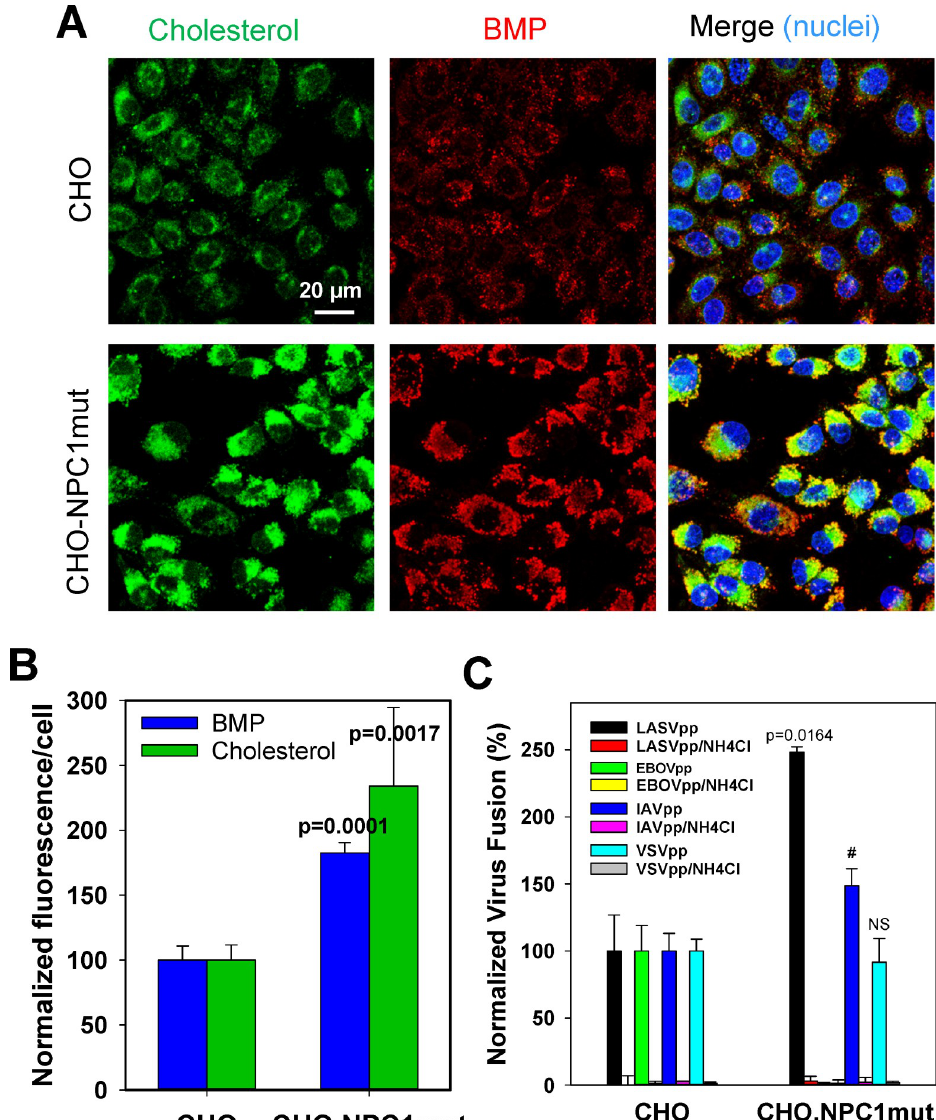
Fig 7. Increased intracellular levels of BMP promote fusion of LASV pseudoviruses. (A) Images of CHO and CHO. NPC1mut cells permeabilized and stained for cholesterol with filipin and for BMP with anti-BMP antibody. Cell nuclei were stained with far-red dye. (B) Quantification of the levels of cholesterol and BMP based on fluorescence intensity per cell after background subtraction. 6 fields of view, each containing ~30 cells were analyzed. (C) Fusion activity of LASVpp, EBOVpp, IAVpp and VSVpp in CHO and CHO.NPC1mut cells measured by a BlaM assay. As negative controls, fusion experiments were carried out in the presence of 40 mM NH 4 Cl. Data are means and SD of two independent experiments performed in triplicate. NS, not significant. (# denotes that, although promotion of IAVpp fusion did not reach significance due to variation between independent experiments, enhancement of IAV fusion was significant in each experiment performed in